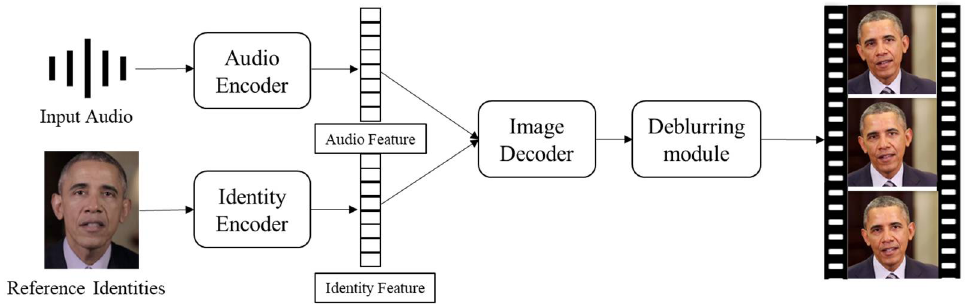
Figure 4. An overview of Specch2vid structure.